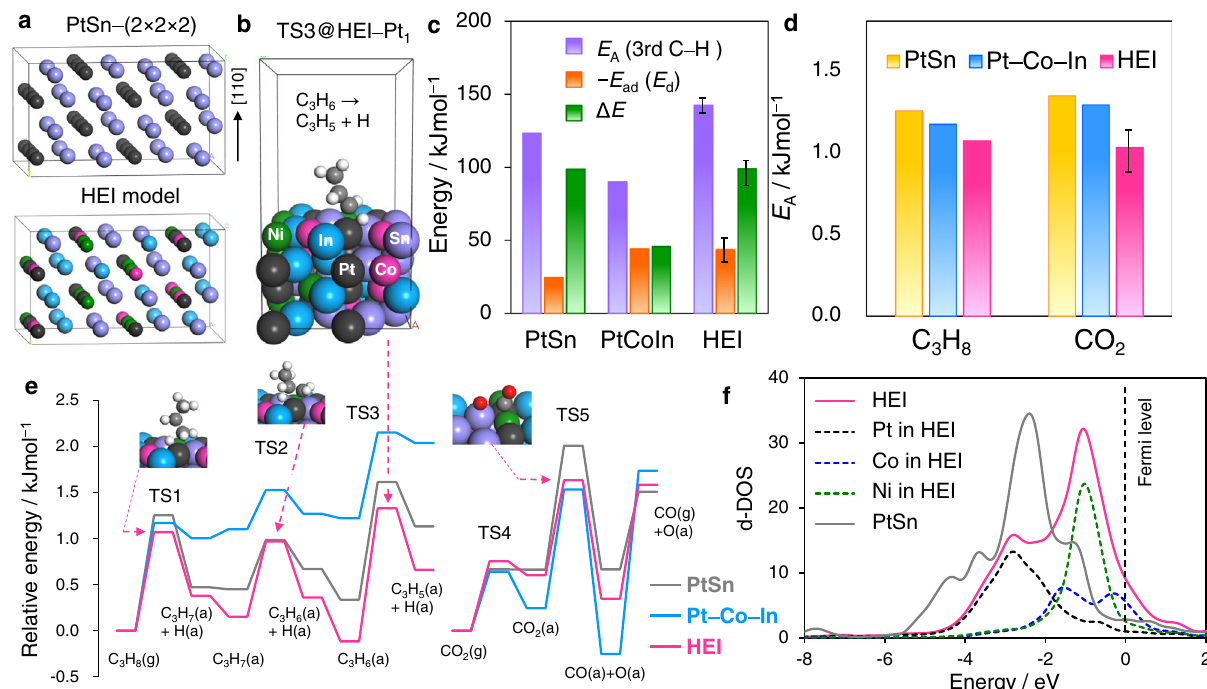
Fig. 5 | DFT calculations. a Model structures of PtSn and the PtSn-based HEI for (average). d E A of propane dehydrogenation and CO 2 activation. For propane DFT calculations. b An example of the HEI slab model for CO 2 -ODP for the over dehydrogenation, E A of the fi rst C – H scission was shown. e Energy diagrams of dehydrogenation: C 3 H 6 → C 3 H 5 +H at a Pt 1 -HEI site on (110) surface (HEI(001):B3). propanedehydrogenationandCO 2 reductiononthesurfaceofPtSn,Pt – Co – Inand c Comparison of E A of the third C – H activation (overdehydrogenation of C 3 H 6 ), HEI. f d-DOS of the surface transition metals on HEI(004):B and Δ E (= E – Co – In, and HEI − E ad ( E d ) of C 3 H 6 , and A + E ad ) on the surface of PtSn, Pt